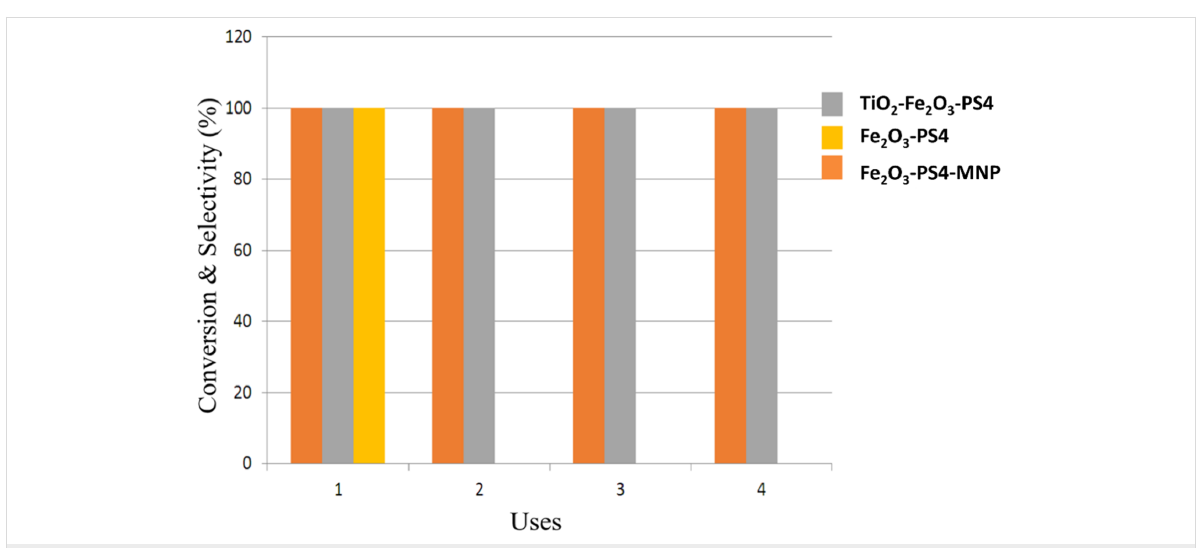
Figure 8: Reusability of the iron oxide/polysaccharide